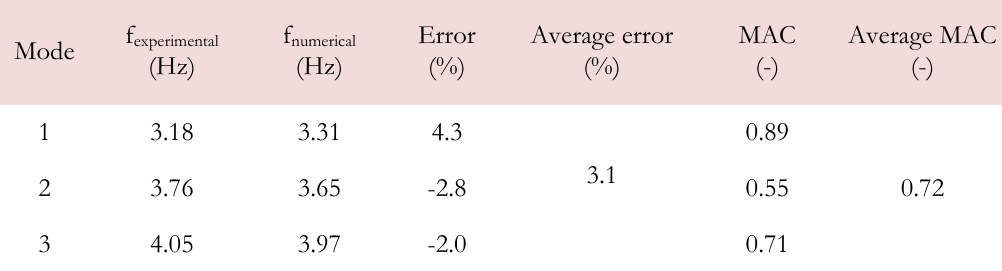
Table 7: Comparison between numerical and experimental frequencies f and mode shapes for the updated values of stiffness of the interfaces.